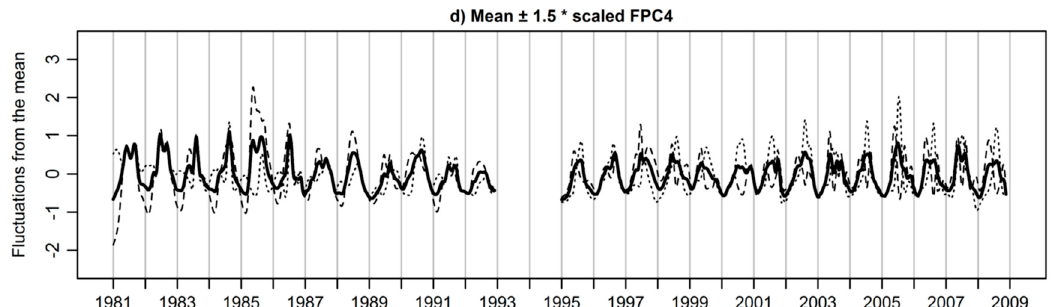
Figure 2. Temporal fluctuations from the mean of all standardized functional variables (solid line) obtained by adding (dashed line) or subtracting (dotted line) the extracted FPCs, each scaled by 1.5 times the square root of its explained variance (panels: a , FPC1; b , FPC2; c , FPC3; and d , FPC4).